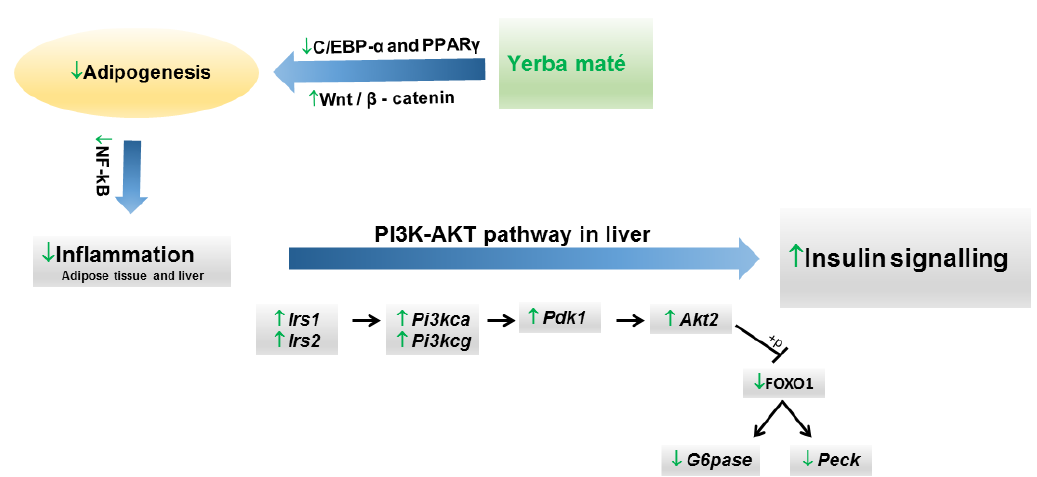
Figure 2. Proposed mechanism of action of yerba maté on the modulation of the PI3K-AKT signaling